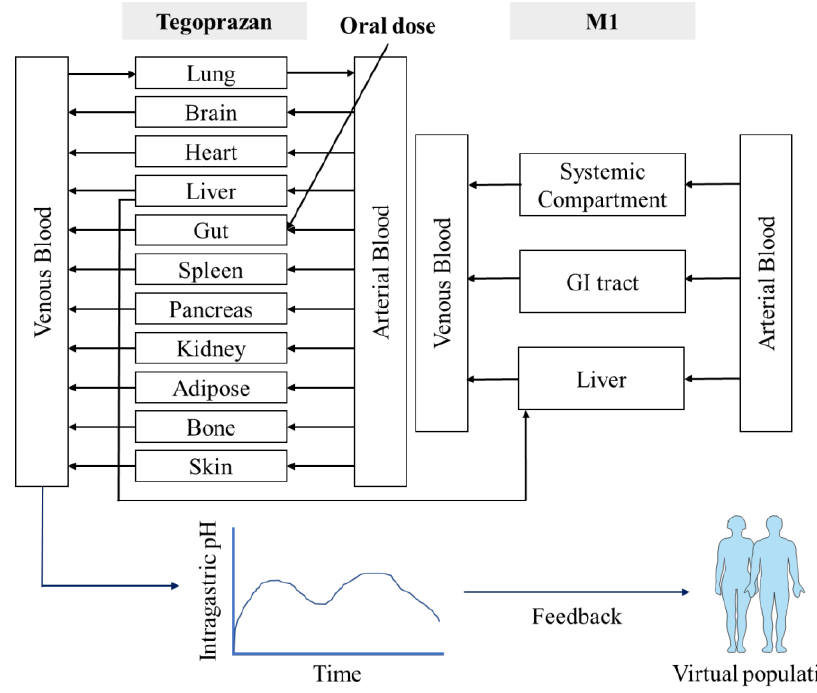
Figure 1. Structure of the tegoprazan-M1 PBPK/PD model.